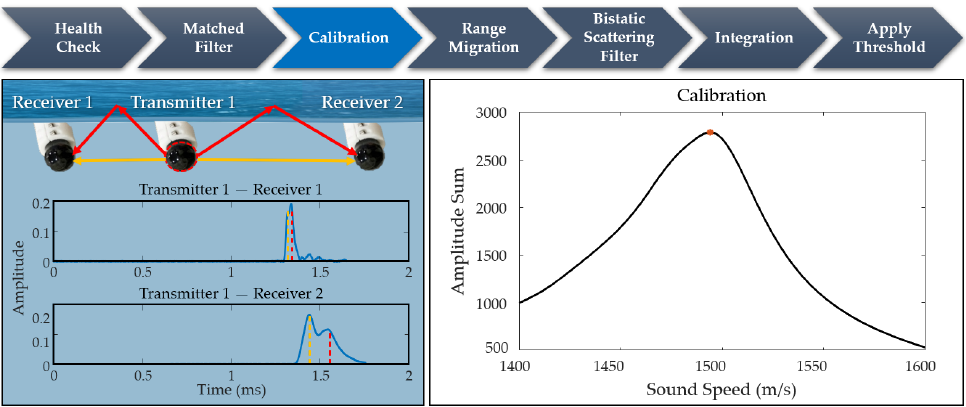
Figure 5. The calibration approach finds optimal sensor positions and sound speed by modeling direct path (orange) and surface bounce path (red) contributions in the matched filtered data